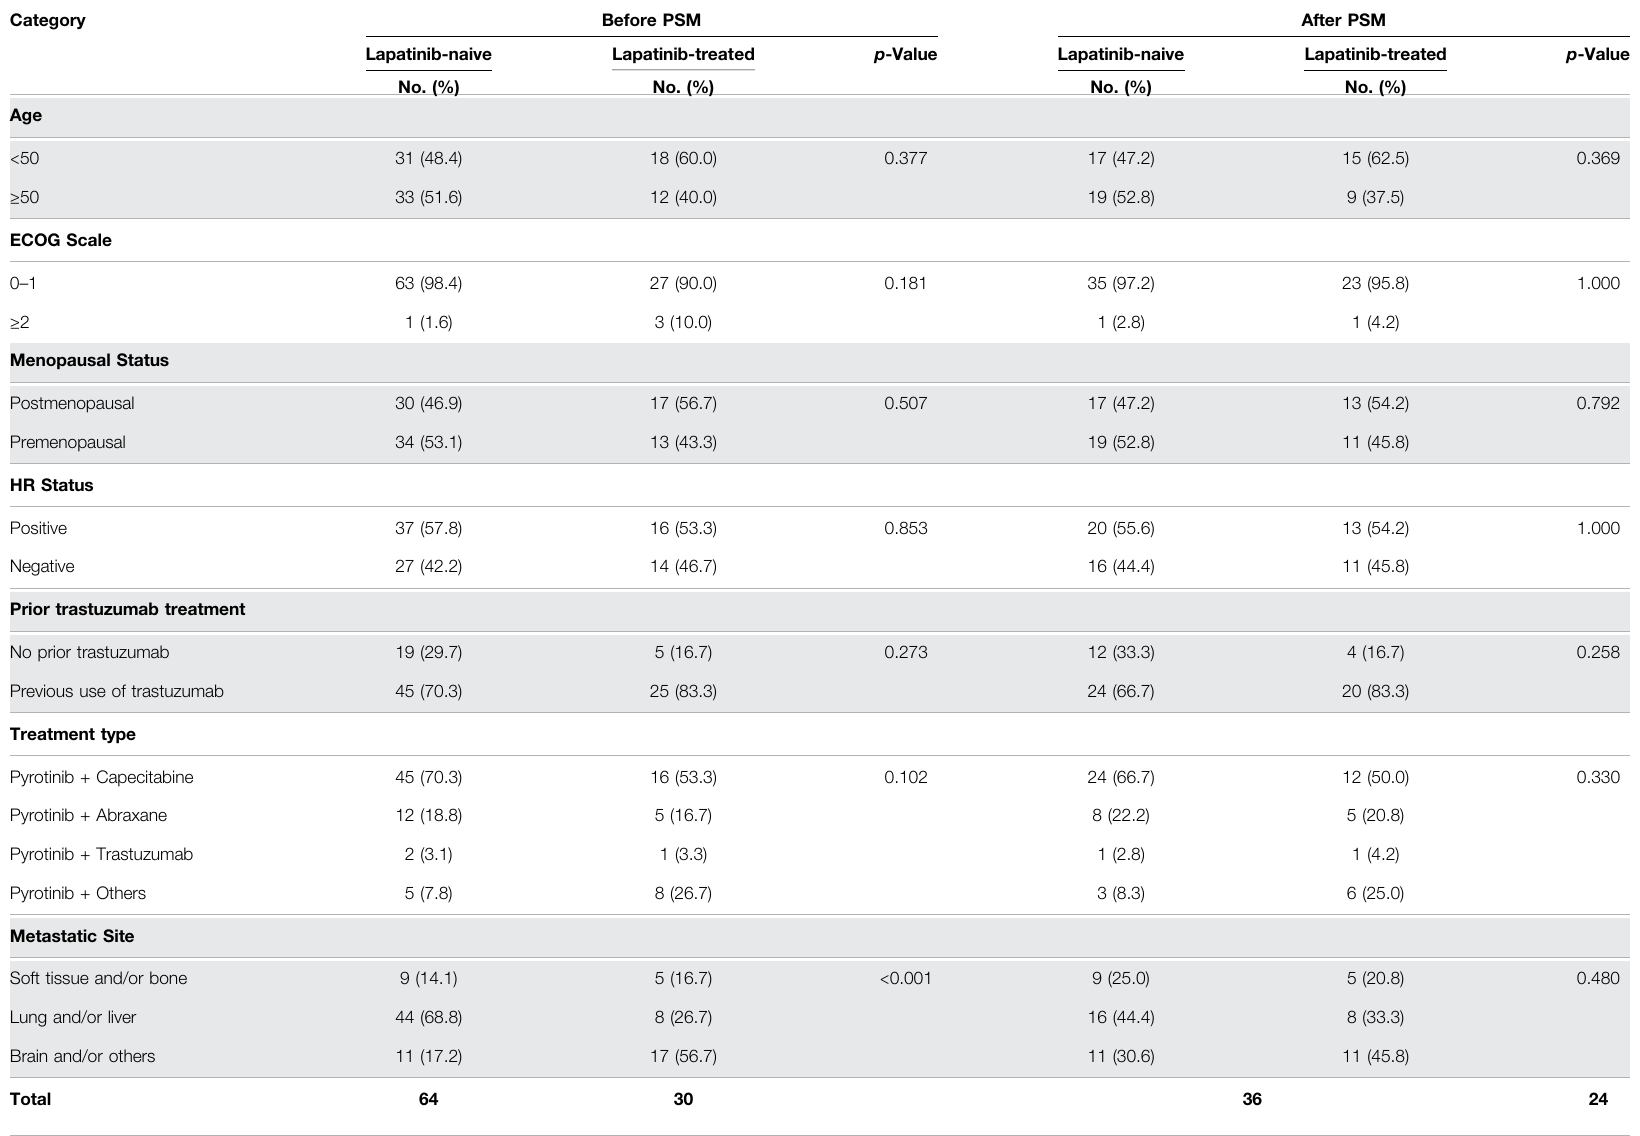
TABLE 1 | Characteristics of patients who received pyrotinib as third- or higher-line therapy who previously were or were not treated with lapatinib. Category Before PSM After PSM Lapatinib-naive Lapatinib-treated p -Value Lapatinib-naive Lapatinib-treated p